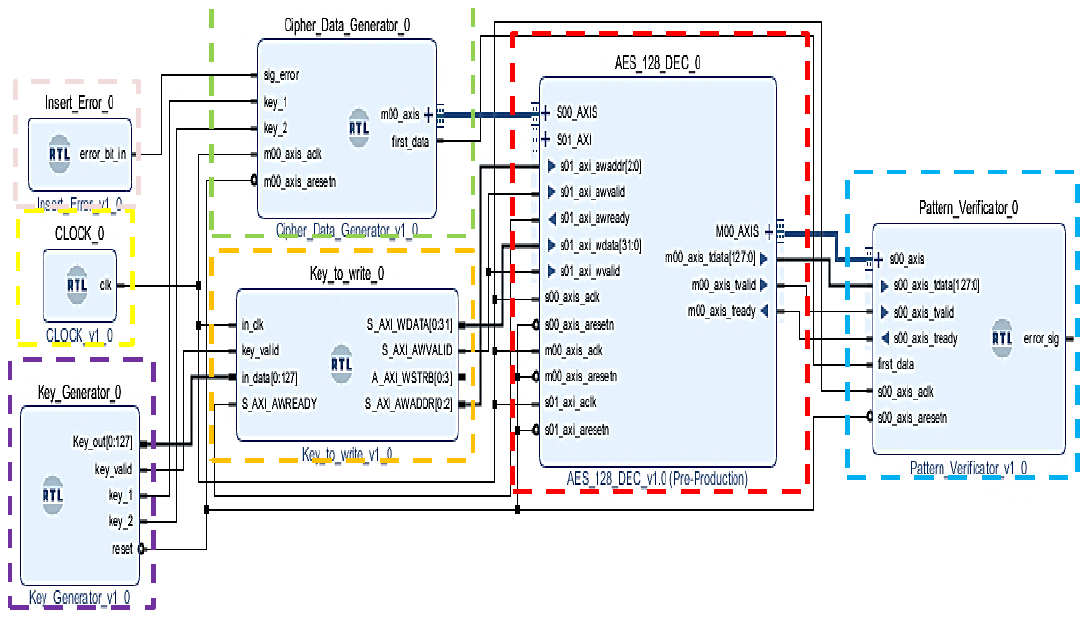
Figure 17. Overall scheme containing the VHDL blocks for both implementing the decryption algorithm and testing it, reproducing the operative scenario of the final application.